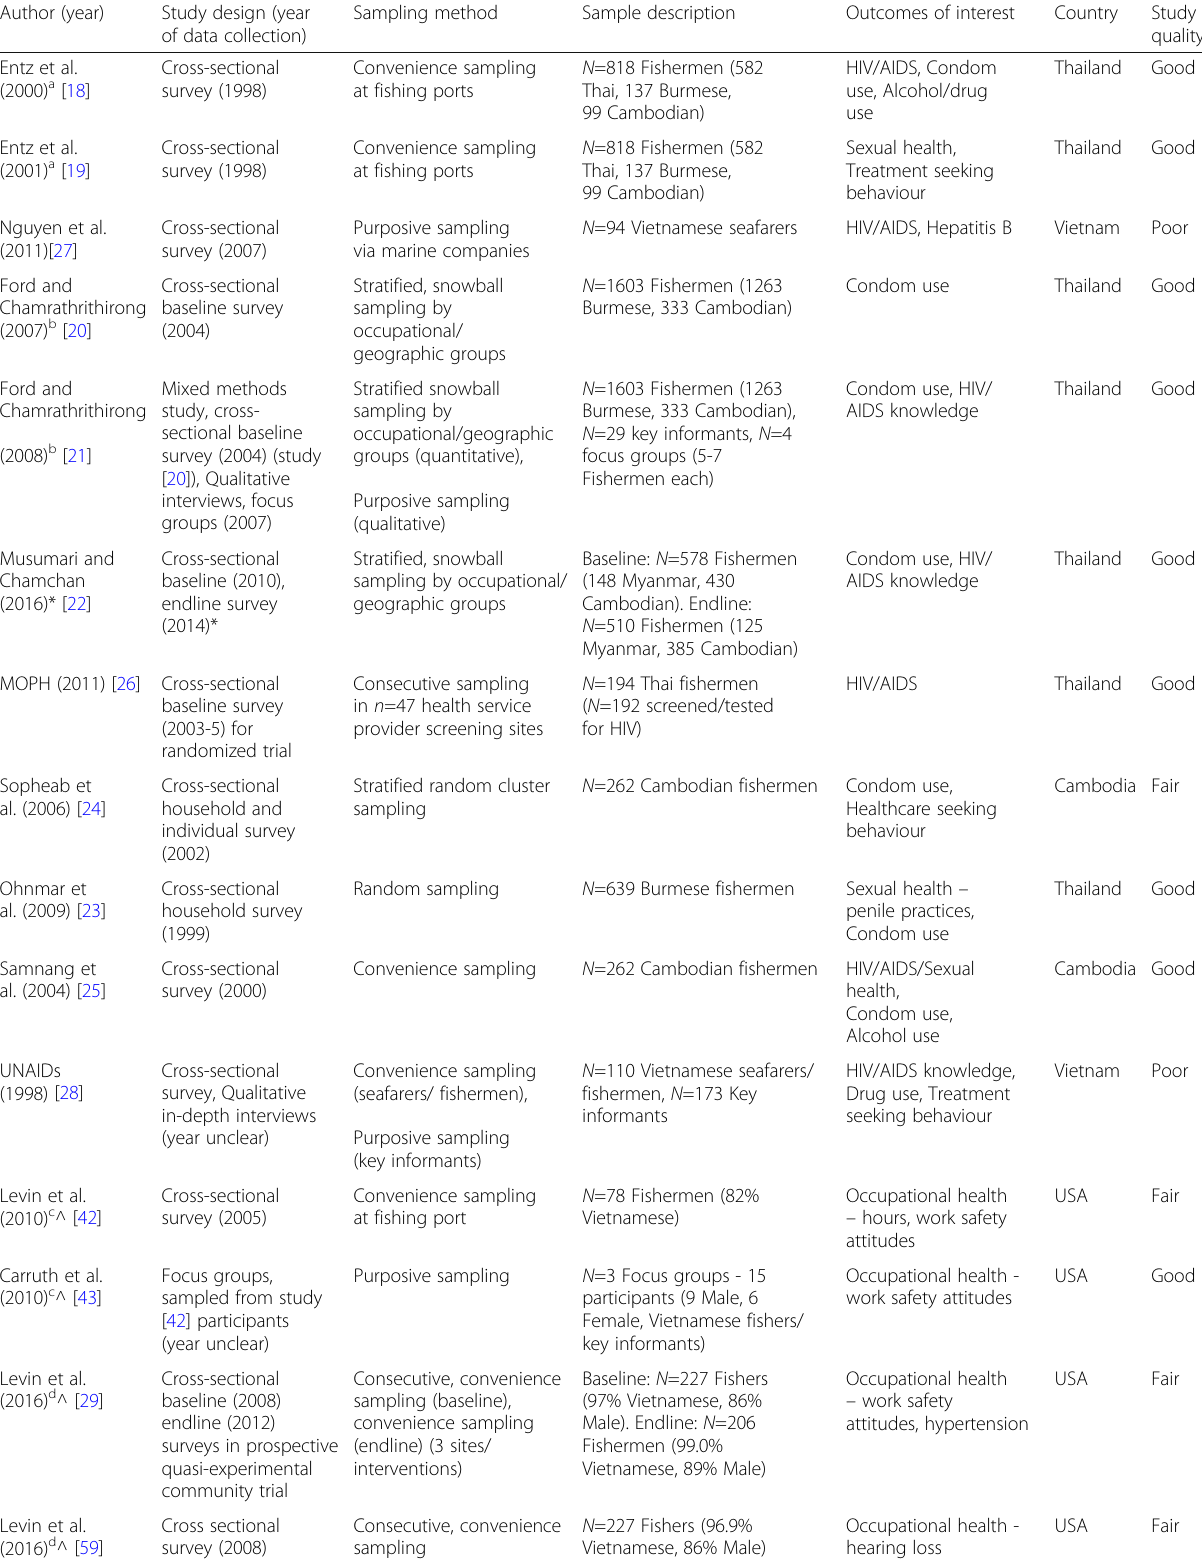
Table 1 Peer-reviewed papers on health from database searches (n=20) Author